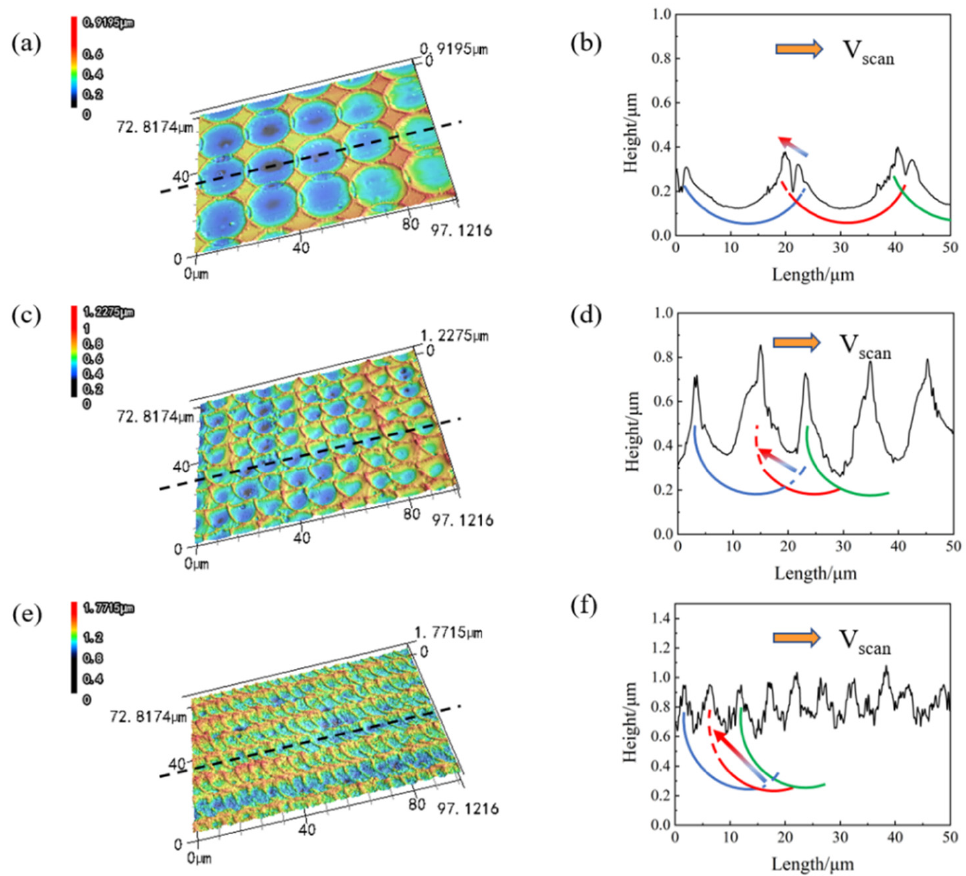
Figure 7. LCM image and cross-sectional view of the laser-textured glass at different scanning distances. ( a , b ) the scanning distance is 20 µ m, ( c , d ) the scanning distance is 10 µ m, ( e , f ) the scanning distance is 5 µ m.